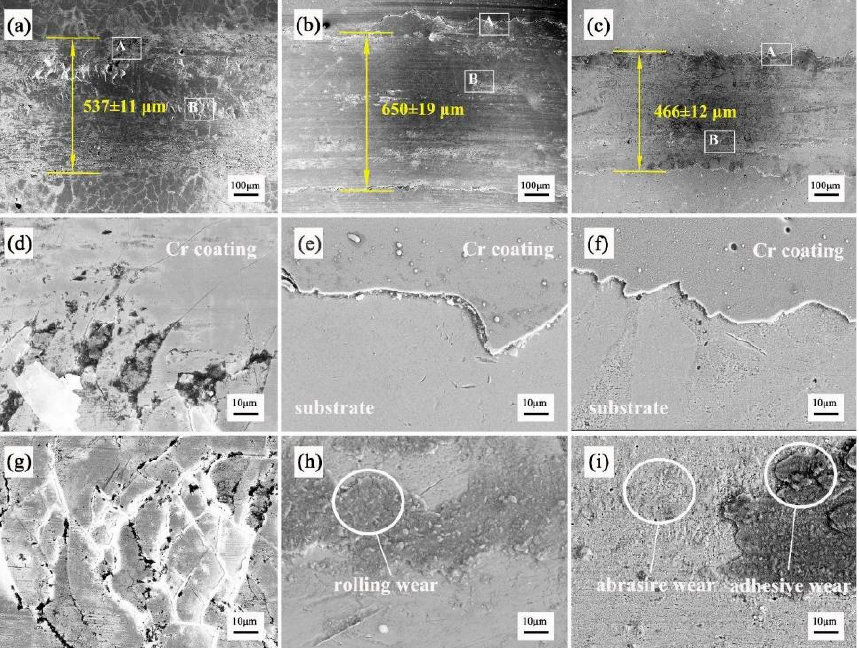
Figure 9. The ampli fi cation of surface wear morphology and the local wear morphology of the three pure Cr coatings ( a , d , g ), EPHC ( b , e , h ), MSIP ( c , f , g , i ) and MAIP ( d , g , e , h ), and ( f , i ) the local ampli fi - cation of positions A and B ( a – c ).